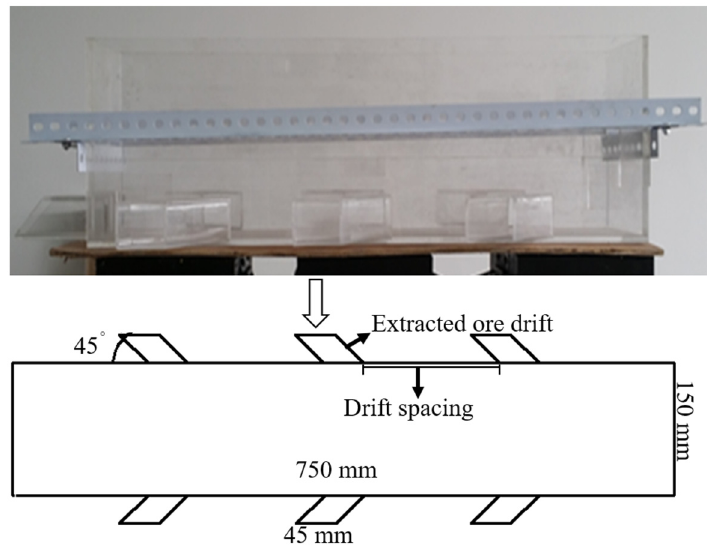
Figure 10. Experimental model diagram.